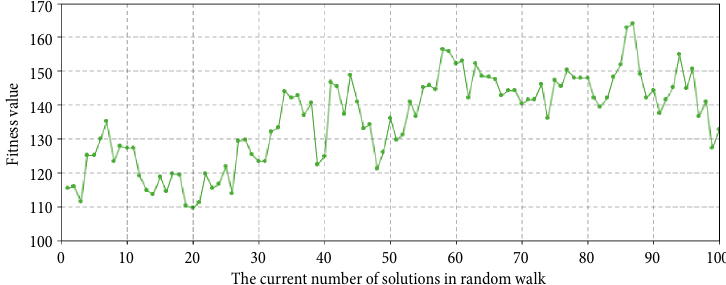
The current number of solutions in random Fig. 3. Fitness values in a random walk on the landscape